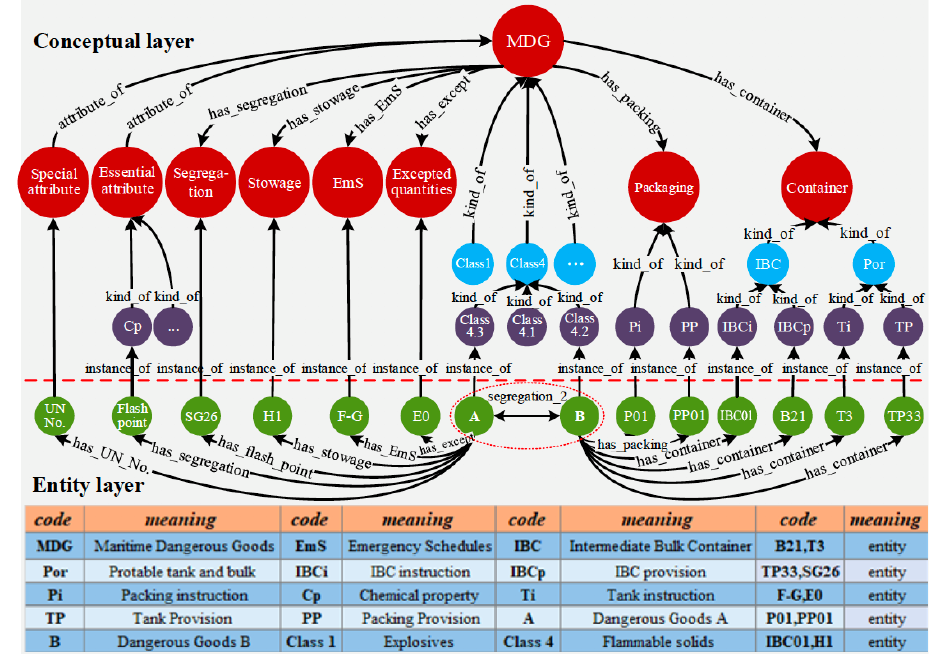
Figure 10. An excerpt of the DMG K-graph